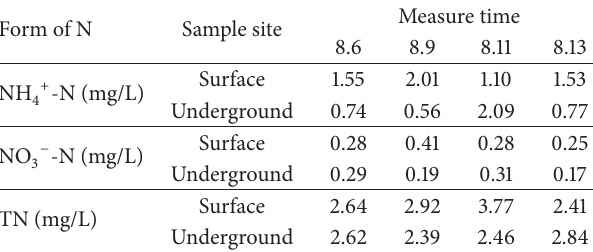
Table 2: The change of the concentration of NH 4+ -N, NO 3− -N, and TN after fertilization at tillering stage in